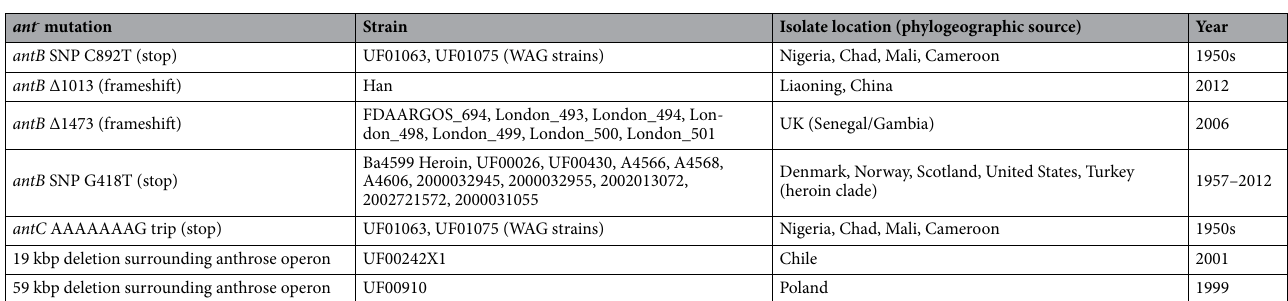
Table 1. Summary of identified ant - mutations, the strains they are found in, geographic source, and date